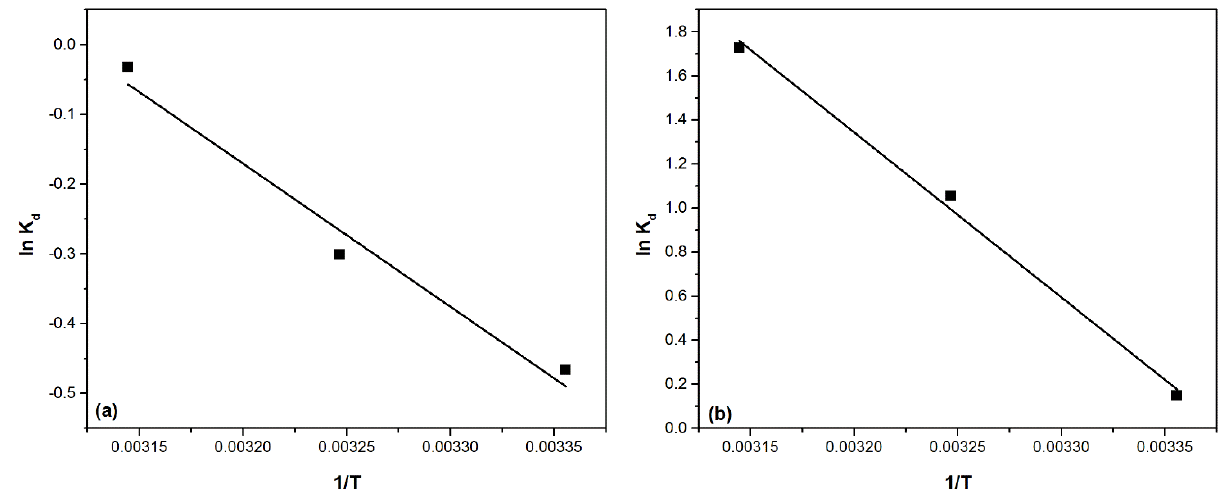
Figure 14. Thermodynamic studies for Pd(II) adsorption onto studied materials: ( a ) MgSiO 3 -DB18C6, ( b ) MgSiO 3 -DB30C10.